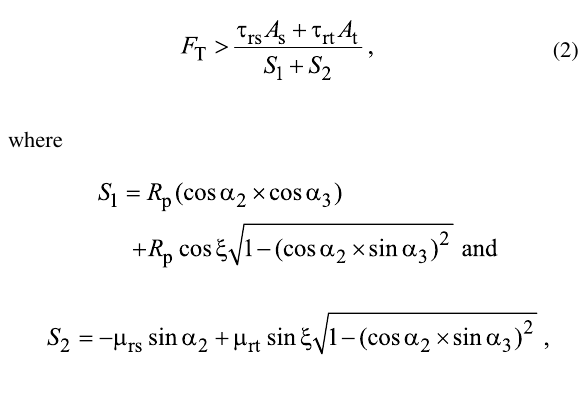
particle–tip contact. Also, a modified Coulomb friction model is